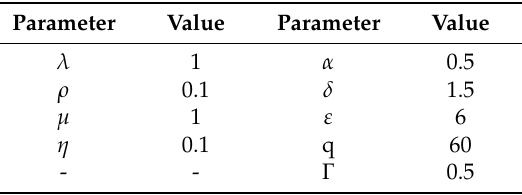
Table 5. The control